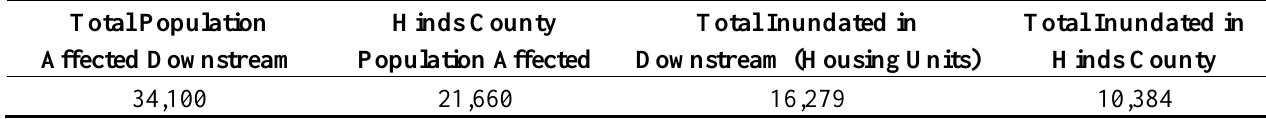
Table 1. Number of population at risk in the downstream and Hinds County region.